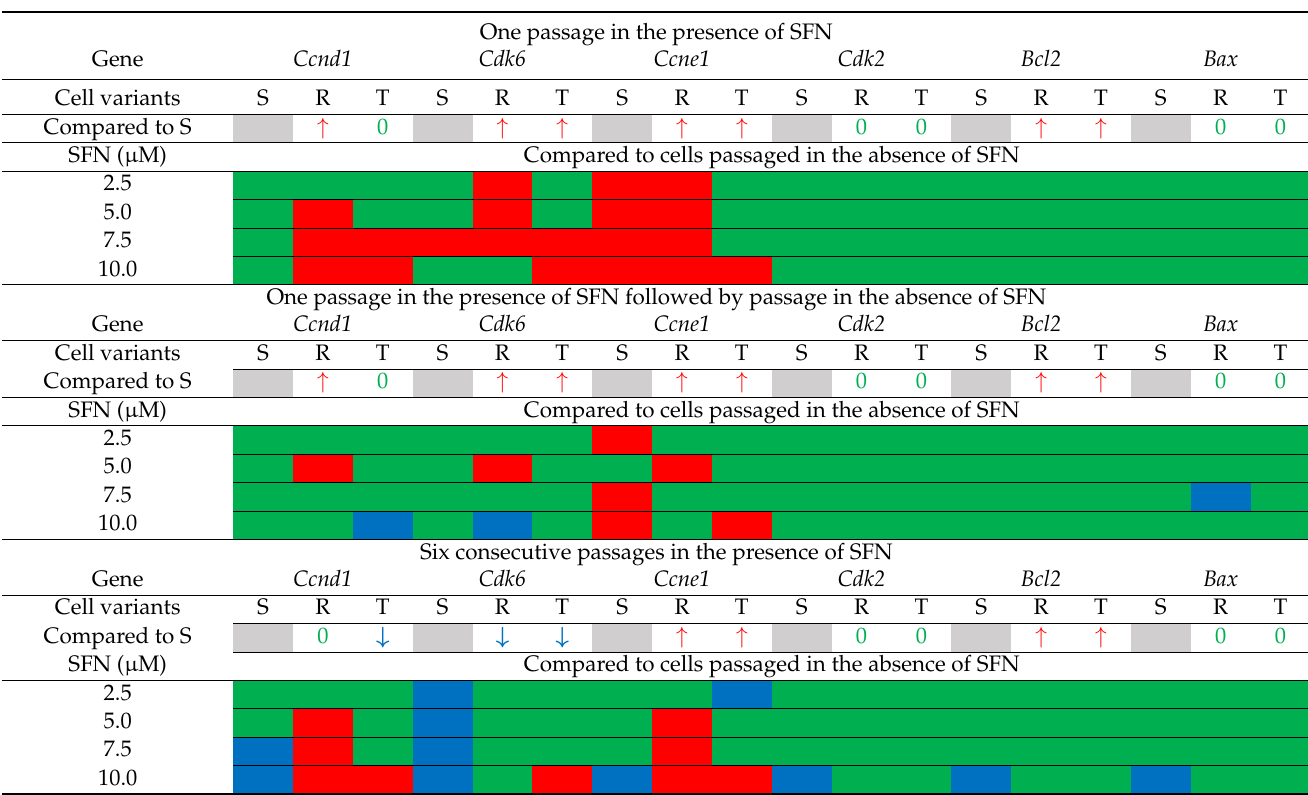
Table 1. Summary of changes in the expression of the indicated genes after different passage procedures of S, R and T cells in the presence of